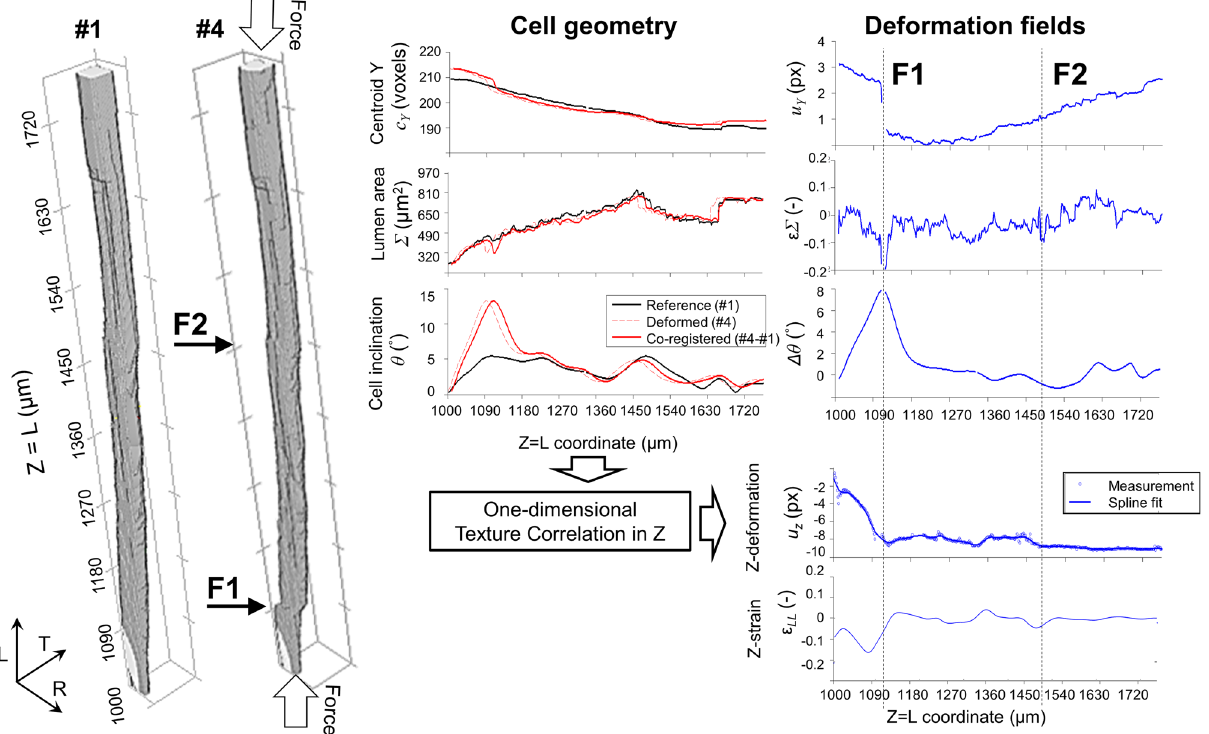
Figure 7. Individual Cell Tracking (ICT) method for single tracheid of L-specimen subject to compression. Based on one-dimensional cell parametrization (Fig. 2), cell geometry parameters are obtained for reference (#1) and densification (#4) states and co-registered with texture correlation in Z. The deformation fields reveal two fracture plane F1 and F2. Buckling ( �θ > 0 ) is observed in F1, while for this cell F2 shows telescopic shortening ( ε LL < 0, ε � < 0 )